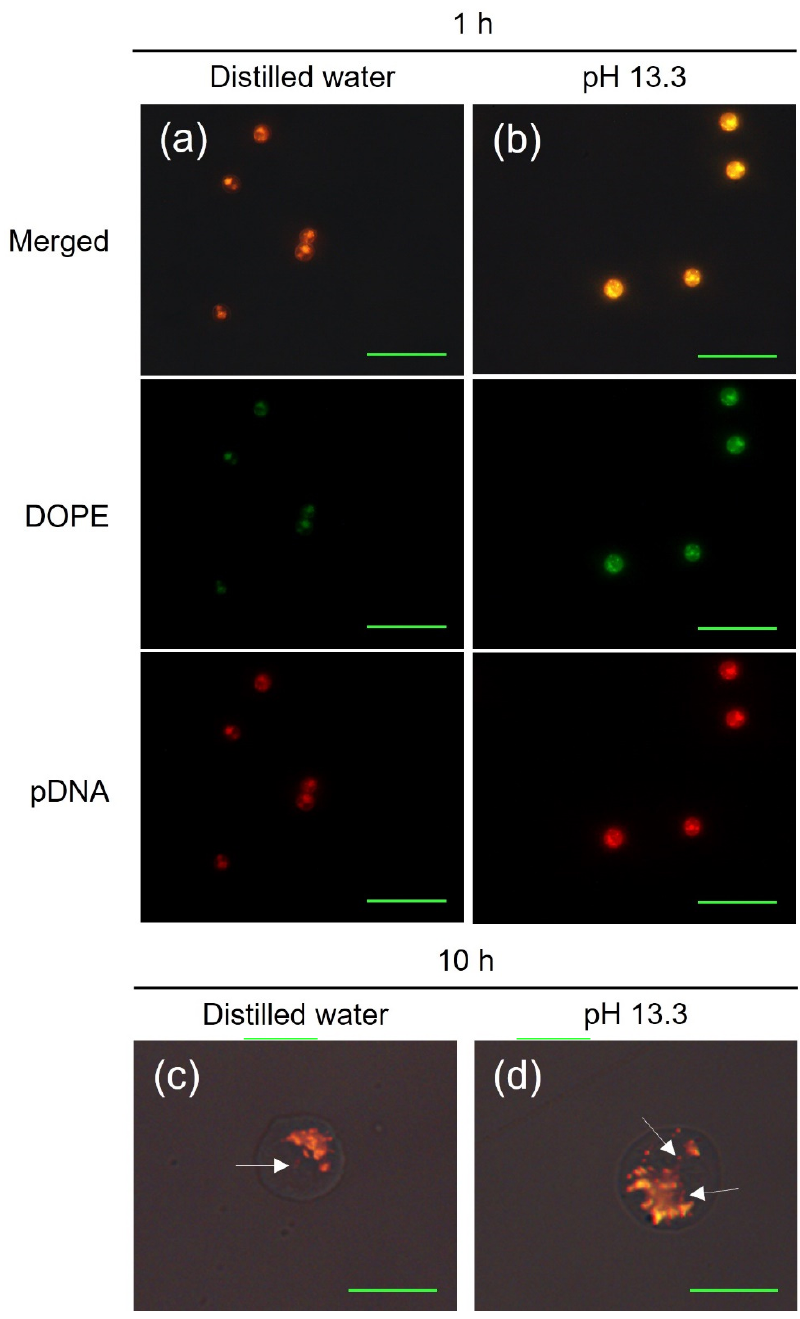
Figure 5. Fluorescence analysis of transfected cells to compare the intracellular distribution of pDNA and DOPE between DW and the pDNA solution of pH 13.3. Fluorescence images ( a , b ) showing the quantity and colocalization (orange) of Cy5-labeled pDNA (red) and Atto 532 dye-labeled DOPE (green) at 1 h post-transfection. Scale bar = 50 µ m. At 10 h post-transfection, the fluorescence images ( c , d ) of transfected cells showed intracellular naked pDNA (red) separated from DOPE (indicated by white arrows). Scale bar = 10 µ m. DOPE, 1,2-dioleoyl- sn -glycero-3-phosphoethanolamine; DW, distilled water; pDNA, plasmid DNA.